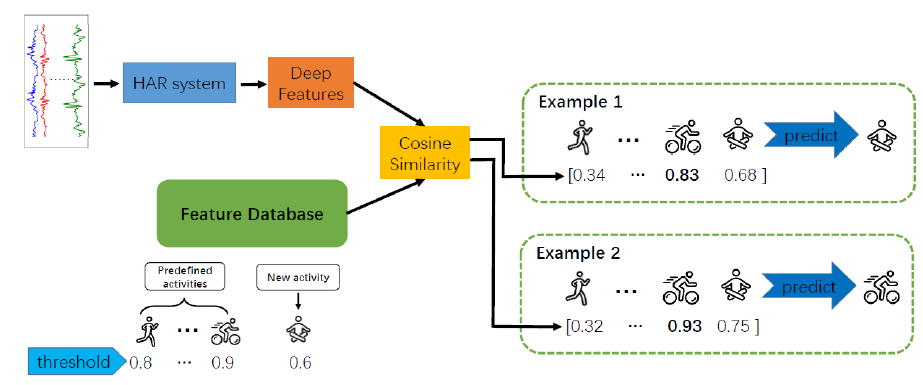
Figure 3. Examples of recognising an activity in open-set human activity